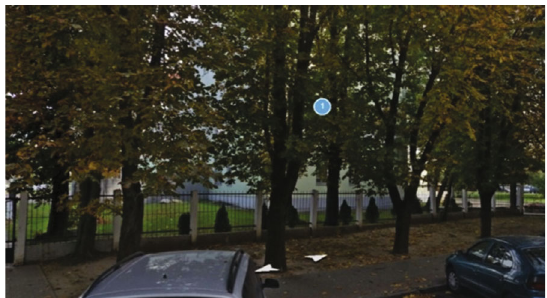
Figure 1: The simulated tree (1) long before breakage of branch (2014).